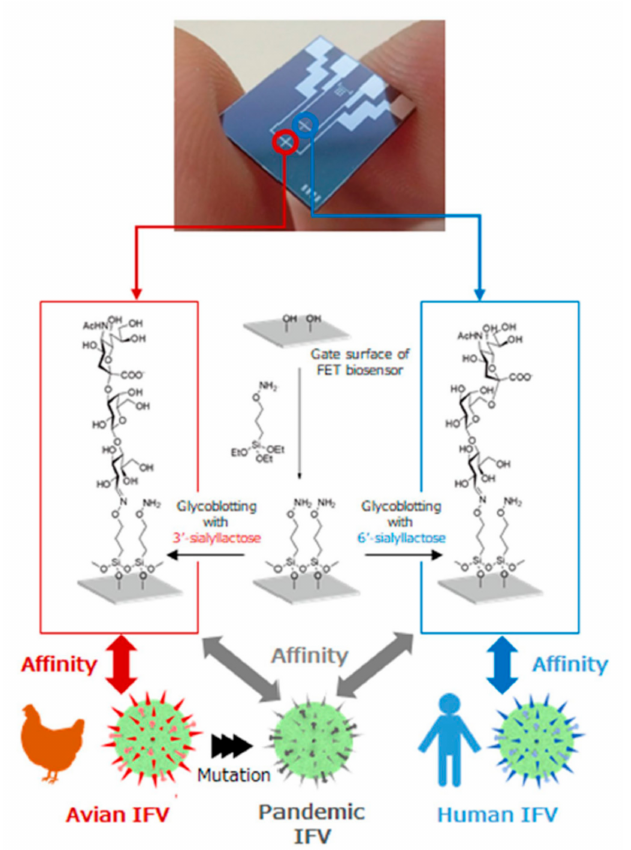
Figure 6. Schematic view of the developed dual-channel field-effect transistor for detection of the Influenza virus and the steps of surface functionalization for specific targets